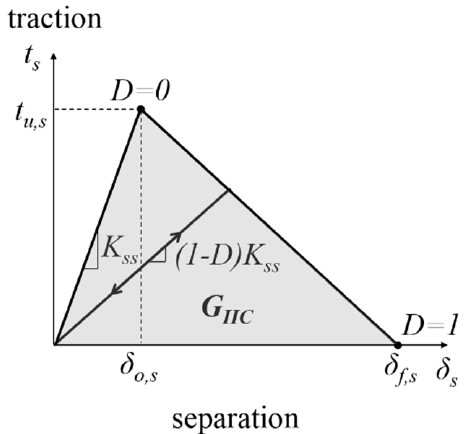
Figure 9. Schematic diagram of the bilinear traction separation law.